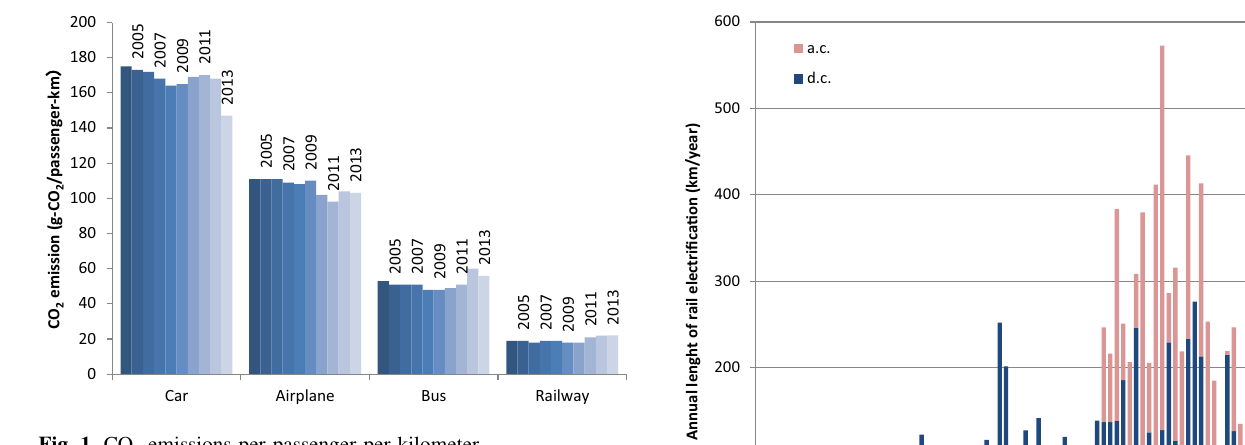
Fig. 1 CO 2 emissions per passenger per kilometer